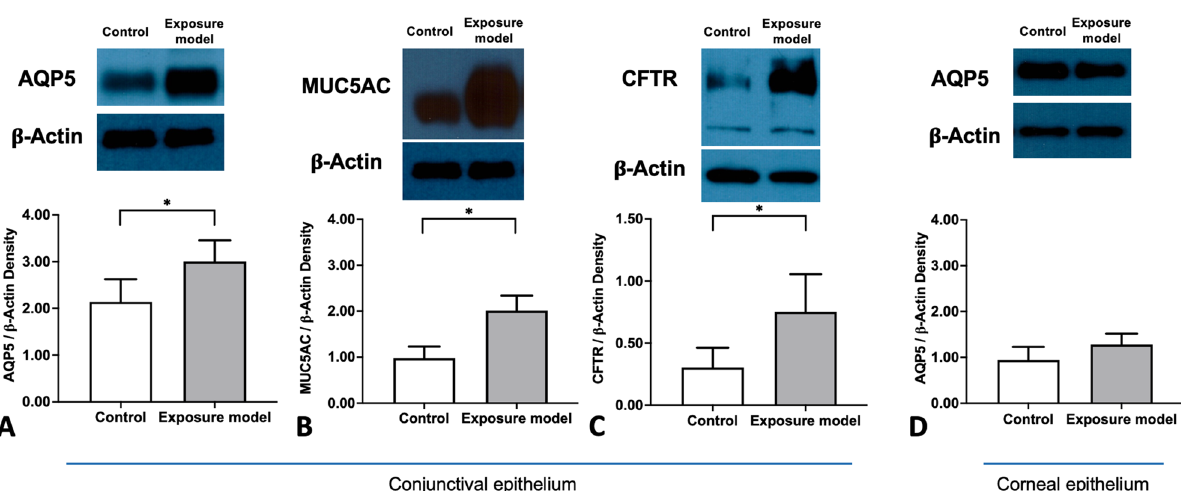
Figure 3. Comparison of the expression of AQP5, MUC5AC, and CFTR in the conjunctiva (A ‒ C) and cornea (D) between the control and exposure models. ( A ) Expression of AQP5. ( B ) Expression of MUC5AC. ( C ) Expression of CFTR. ( D ) Expression of AQP5 in the cornea. Original blots of Fig. 3A-3D are presented in Supplementary Figure